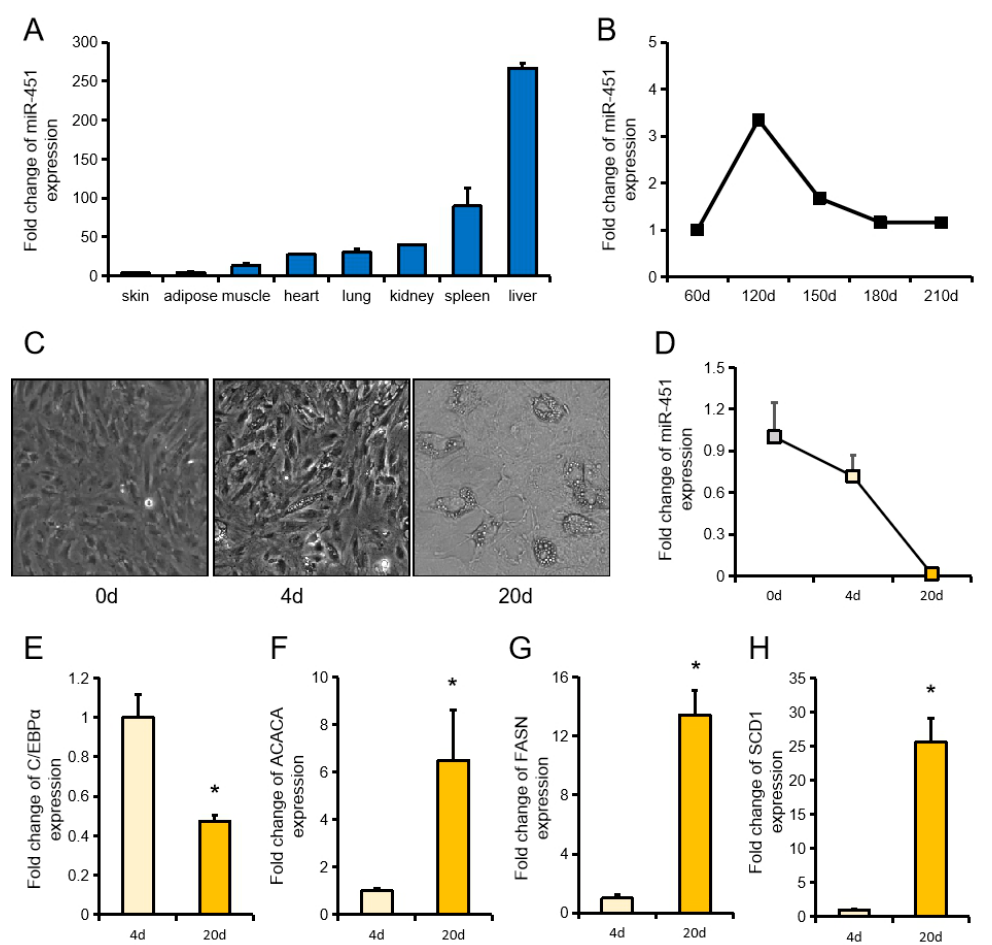
Figure 1. Expression characteristics of ssc-miR-451. ( A ) ssc-miR-451 tissue expression profile on pigs (Three 3-week-old meal Duroc × Landrace × Yorkshire (DLY) piglets), the expression of mir-451 in skin tissue was designated as “1”. ( B ) Expression of miR-451 in large white pigs of different days, data source [21]. ( C ) Diagram of different stages of differentiation of porcine primary adipocytes. ( D ) Changes of ssc-miR-451 expression in porcine primary adipocytes. ( E – H ) Expression of lipid deposition-related genes during differentiation of pig primary cells at 4d and 20d, ( E ): CCAAT enhancer binding protein alpha (C / EBP α ), ( F ): Acetyl-CoA carboxylase alpha (ACACA), ( G ): Fatty acid synthase (FASN), ( H